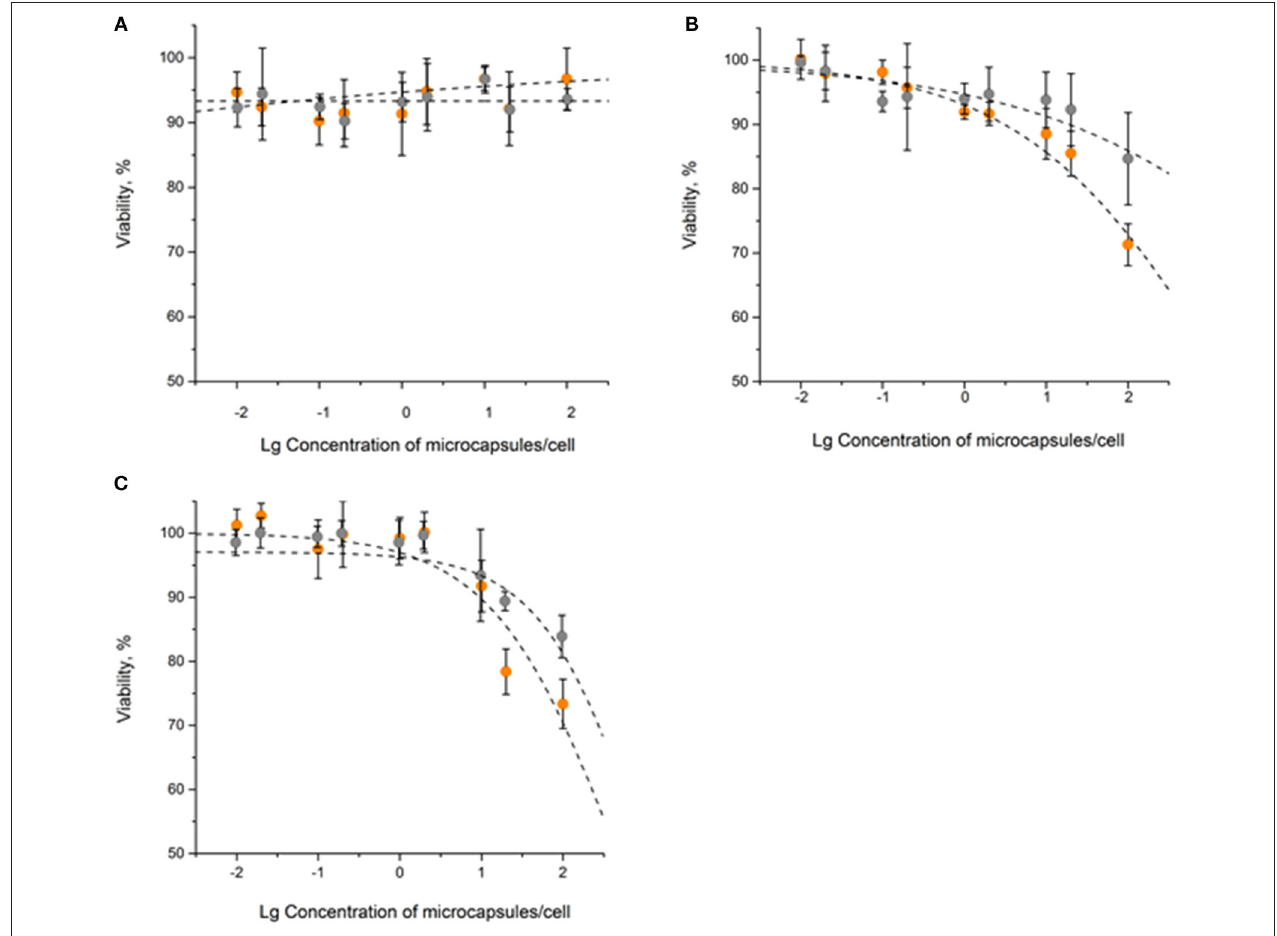
FIGURE 2 | The in vitro cytotoxicity of the QD-encoded microcapsules (orange circles) and placebo microcapsules (gray circles): (A) 24h, (B) 48h, (C) 72h.